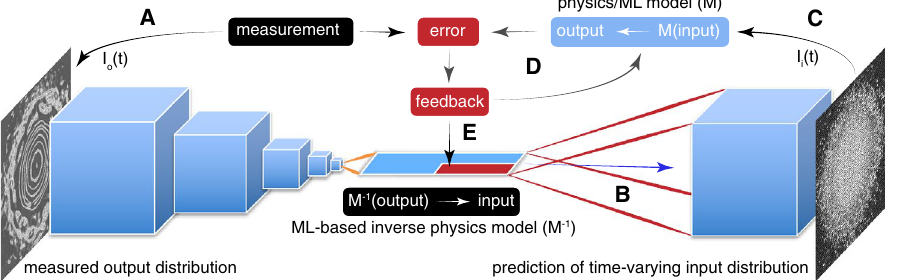
Figure 2. Overview of an adaptive ML approach for ML-based time-varying inverse models. In our application a convolutional neural network is trained to represent an inverse physics model M − 1 which maps an output distribution I o ( t ) to its associated input distribution I i ( t ) for a complex system ( A , B ). The ML-based estimate of the input I i is then fed into a physics or ML-based surrogate model ( C ) and the model’s output is compared to measurements to quantify an error which is used to guide iterative feedback ( D ). In this adaptive approach the dense layers of the network include inputs from an adaptive feedback loop which are perturbed based on model or measurement-based errors ( E ).